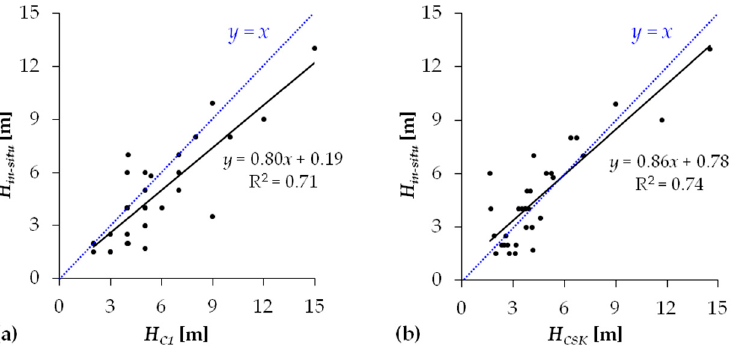
Figure 18. Validation of height ( H i ) values derived from ( a ) CartoSat-1 DSM and ( b ) COSMO-SkyMed DEM against in situ measurements. The latter are according to the values in [49].